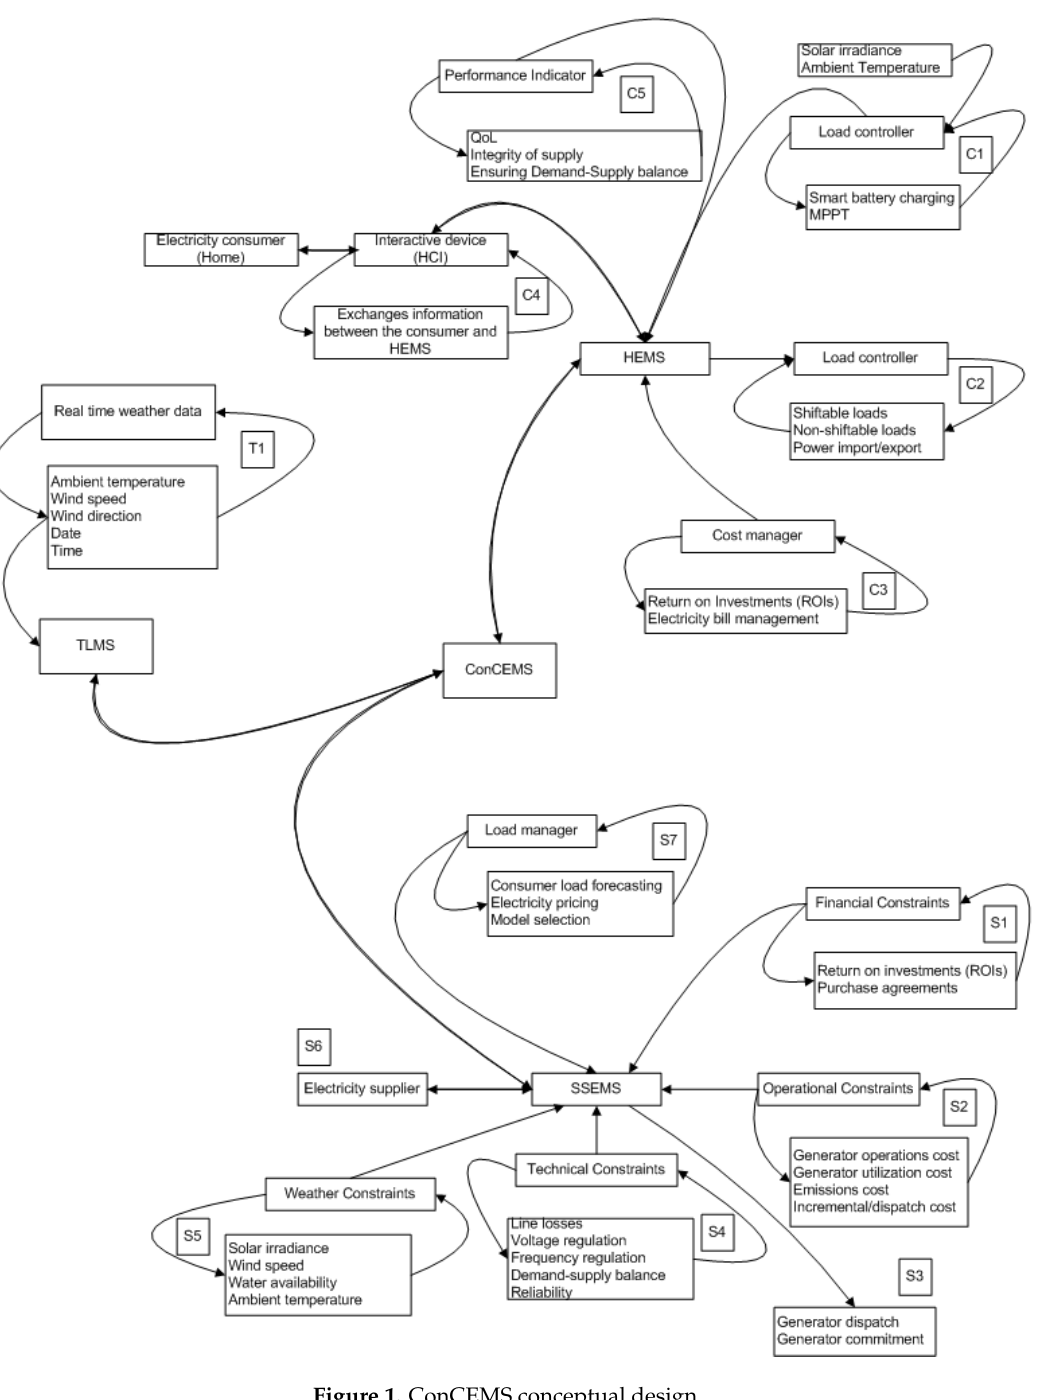
Figure 1. ConCEMS conceptual